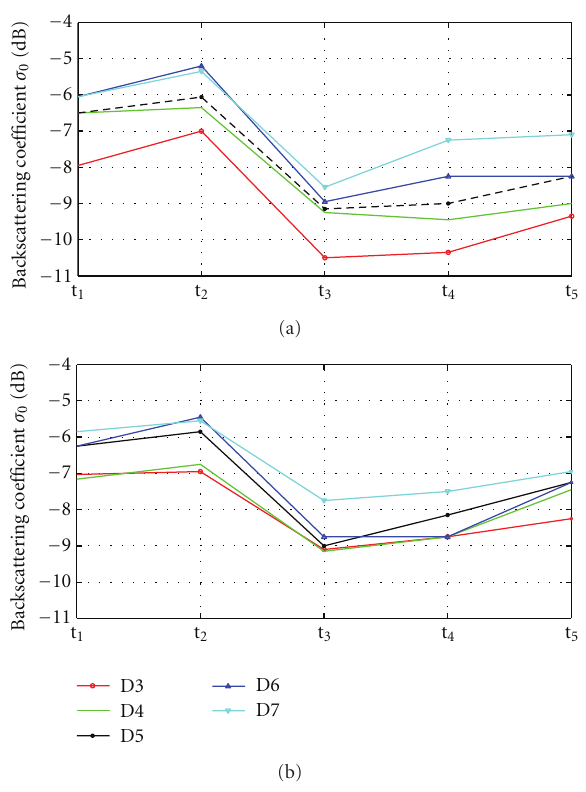
Figure 6: Mean backscattering coe ffi cient measured for each RADARSAT-1 image and soil drainage class under (a) bare soil conditions (LUT = N 1 + N 2 ) and (b) vegetative cover conditions (LUT = C + P + F +